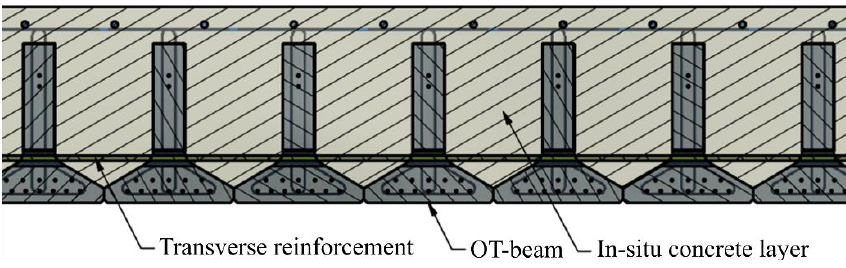
Figure 1. Section of an OT-slab.